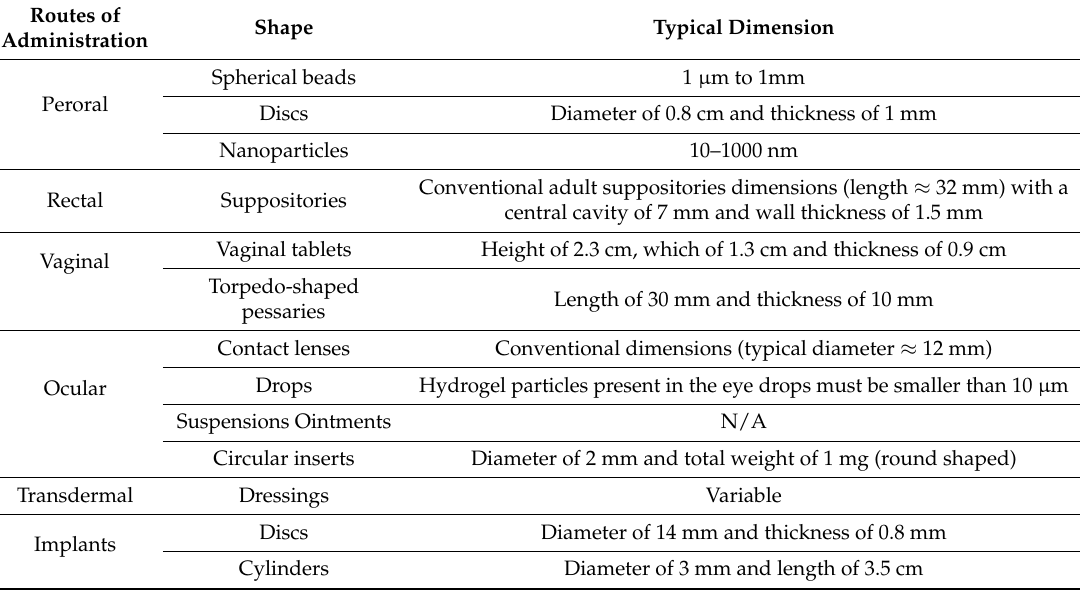
Table 1. Different types of hydrogel products administered via different routes of administration